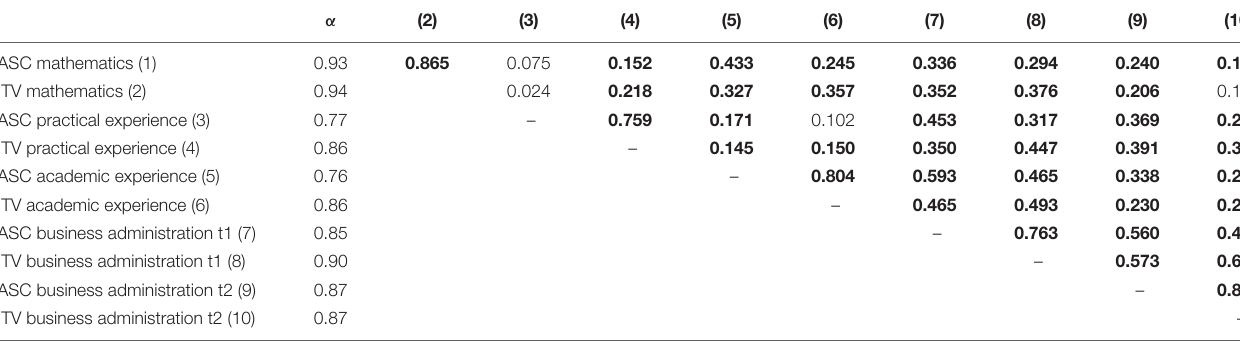
TABLE 4 | Internal consistency of manifest scales and bivariate correlations of latent scale